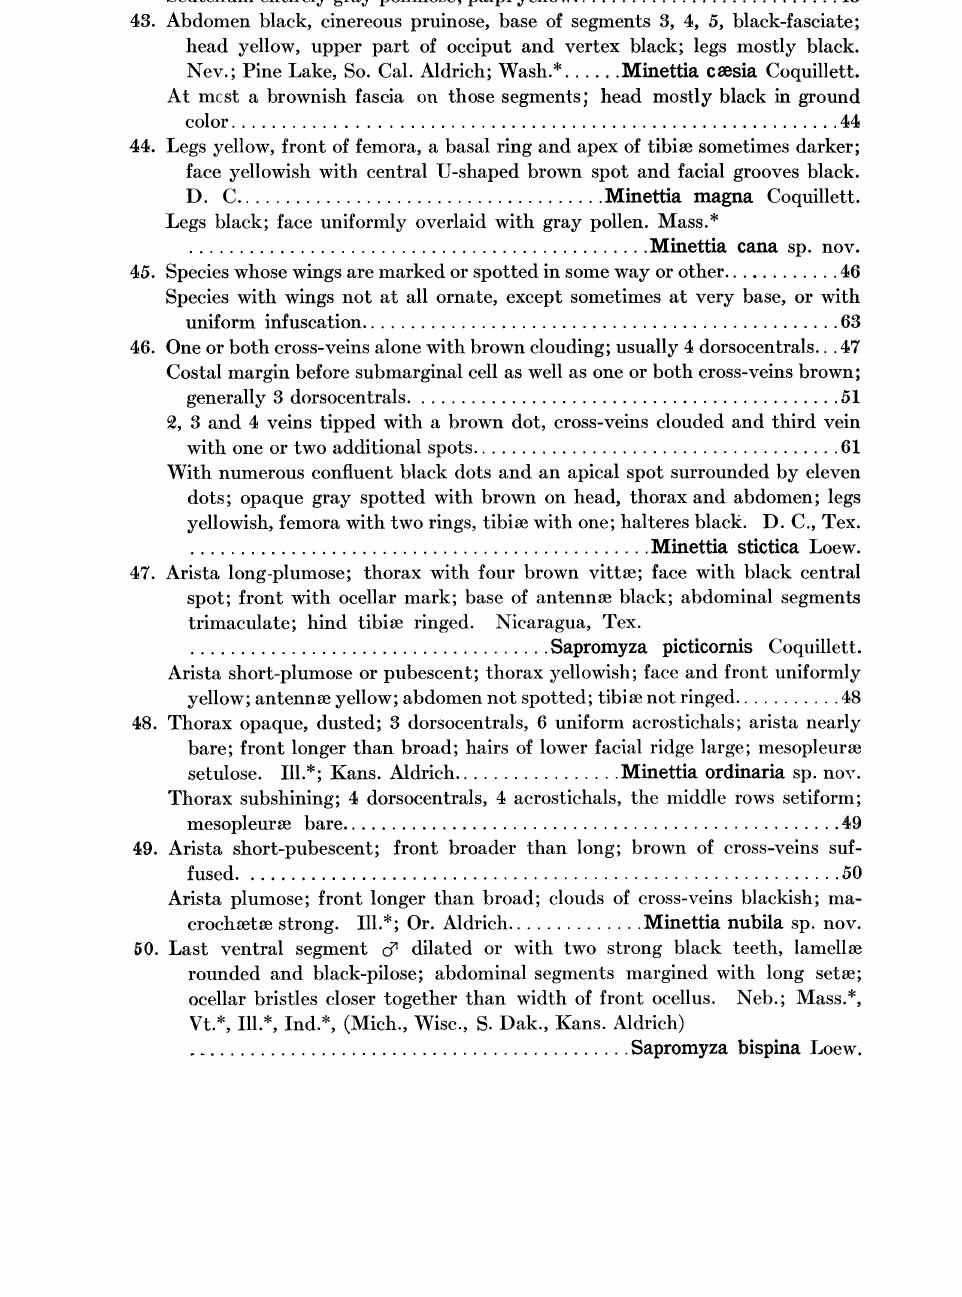
lYiinettia magna Coquillett. Minettia eana sp.